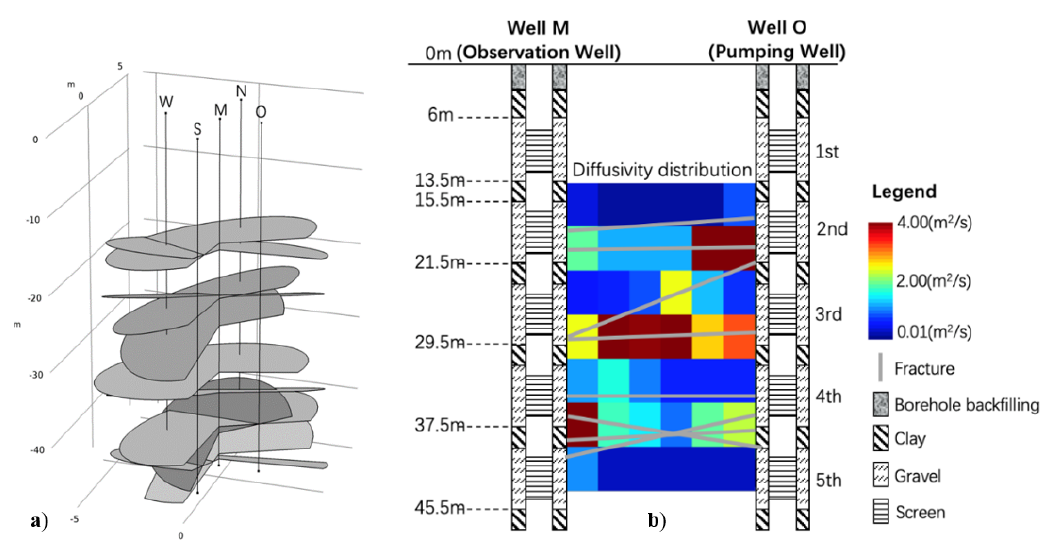
Figure 17. ( a ) 3D fracture geometry model [37]. ( b ) Comparison of the 2D inversion result and the 2D fractures exported from ( a ).